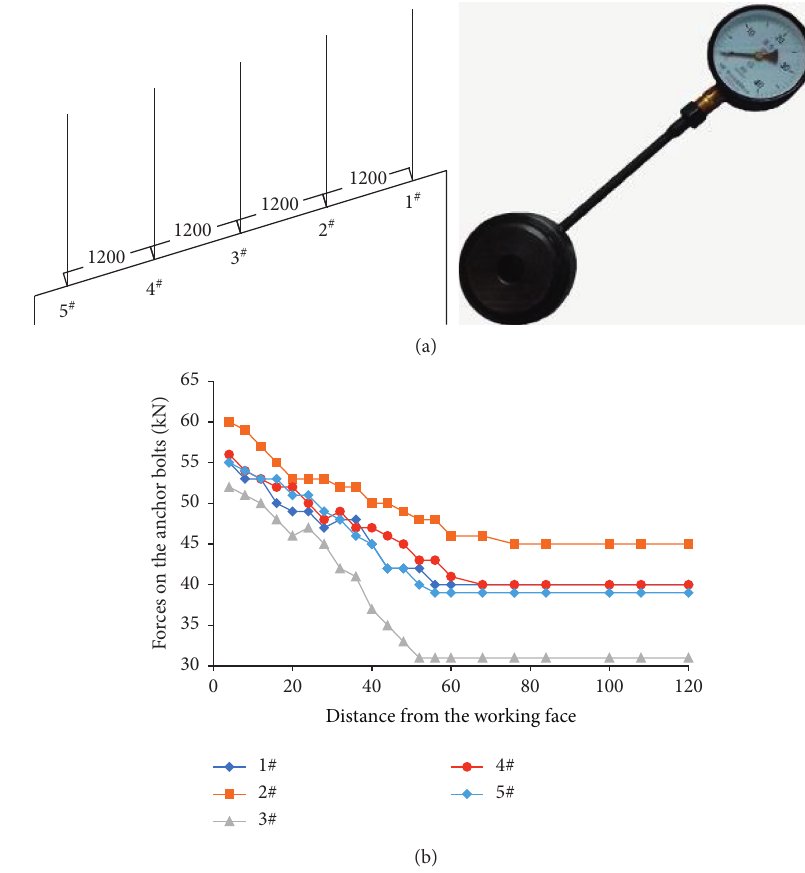
Figure 17: Rock bolt force of 1905S haulage entry. (a) Bolt dynamometer and number. (b) Bolt